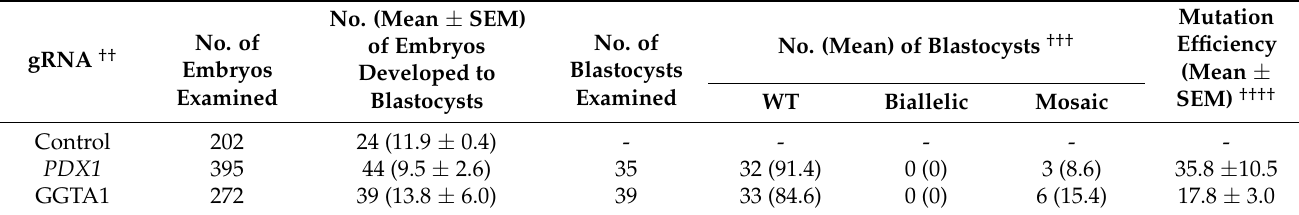
Table 1. Development of zona pellucida (ZP)-free embryos subjected to lipofection-mediated gene editing with gRNA targeting PDX1 or GGTA1 during in vitro fertilization (IVF) † .